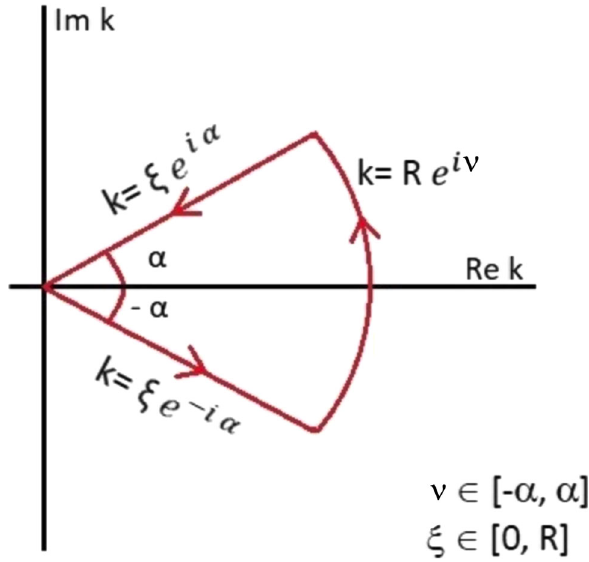
Fig. 1 Complex contour that encloses all the zeroes of f θ ( k ) . We take R → ∞ and α a constant